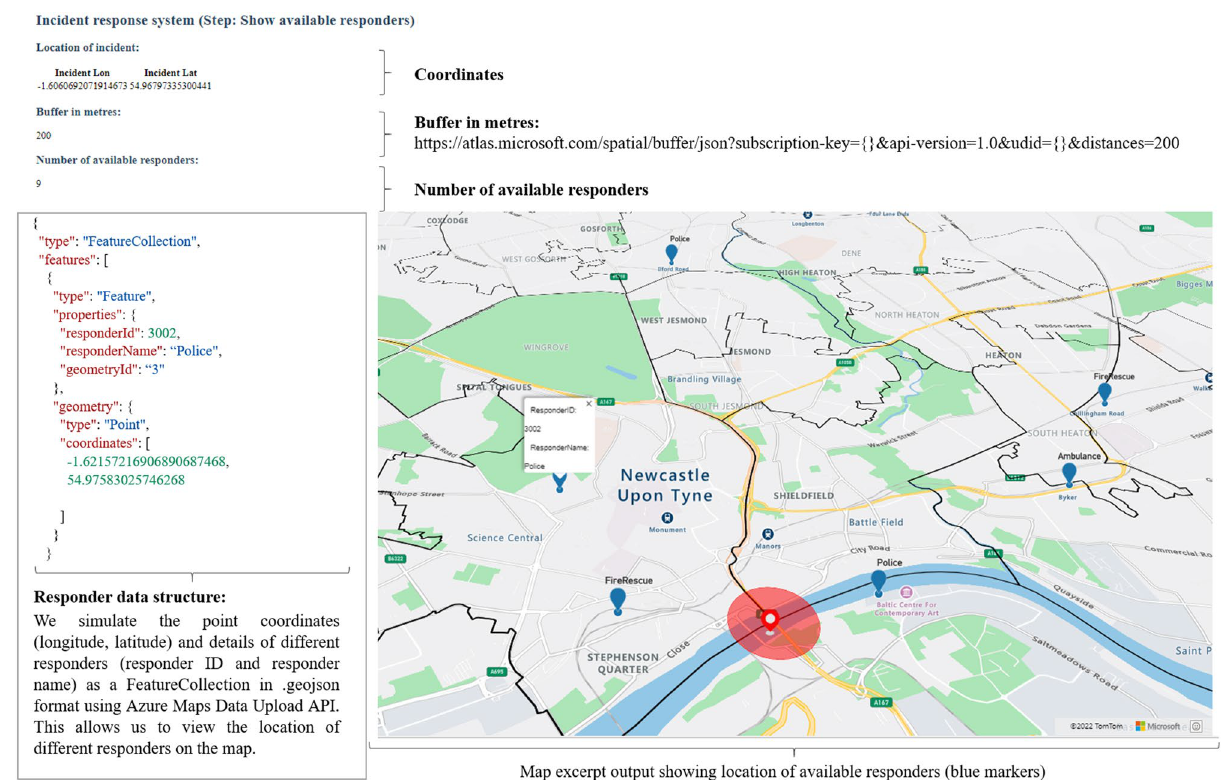
Figure 4. Incident process step 3: View location of available responders (own figure). The web application shows the indicators: Location of incident (longitude, latitude); buffer in metres; and the number of available responders. The code excerpt displays a .geojson file containing the information for a simulated responder (responder ID, responder name, longitude and latitude coordinates). The map output visualises the location of the incident on the Tyne Bridge with a red marker and the location of available responders with blue markers. KW created the map output using the Microsoft Azure Maps Web Software Development Kit and TomTom ( © 2022) base map data (a subscription key to use the data can be obtained after registering on the Azure Maps platform for Geospatial Mapping APIs under https:// azure. micro soft. com/ en- us/ servi ces/ azure- maps/# azure maps- overv iew). The code for the web application was developed in JavaScript, CSS and HTML in the Microsoft Visual Studio Code integrated development environment (version 1.70.2) and Node.js (version 16.13.2) on